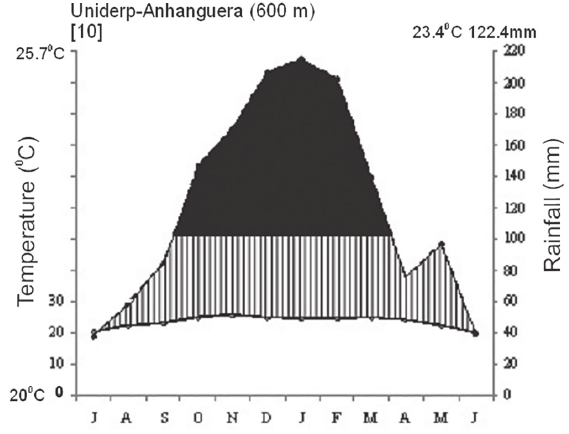
Figure 4 - Ordination through Principal Component Analysis (PCA) of the eight plots analyzed on an escarpment slope of the Serra de Maracaju, Mato Grosso do Sul, Brazil. The percentage of cumulative variance explained by the two axes is 39.34 and 59%. (P.Resin = phosphorus, M.O.= organic matter, K= potassium, Ca= calcium, Mg= magnesium, Al= aluminum, S= sulfur, B= boron, Cu= copper, Fe= iron, Zn= zinc, Mn= manganese).